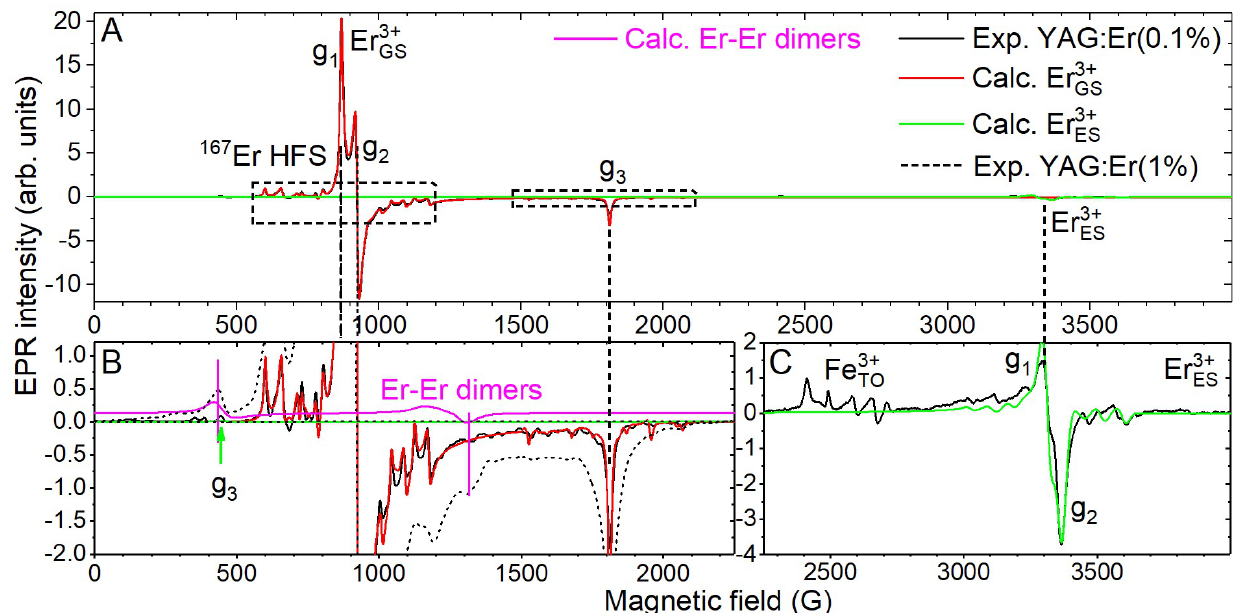
Figure 3. ( A ) Experimental EPR Er 3 + and Er 3 + signals measured in the YAG:Er (0.1%) samples at 10 K shown along with the calculated ones (see the legend). ( B , C ) Closeups of the panel A. Additionally, the closeup of the experimental YAG:Er (1%) spectrum as well as calculated Er–Er dimers are also indicated. g 1–3 and arrows indicate the spectral position of the g tensor values contributions for both Er 3 + and Er 3 + . Dashed oblongs stress hyperfine structure (HFS) due to 167 Er nucleus. Table 2. Spin-Hamiltonian parameters from Equations (2) and (3). The error of g i ( i = 1–3) determination is ±0.0005. The error of A i ( i = 1–3) determination is ±10. The error of Q i ( i = 1–3) determination is ±1. The error of K i ( i = 1–3) determination is ±1. K i is related only to the Er–Er dimer.